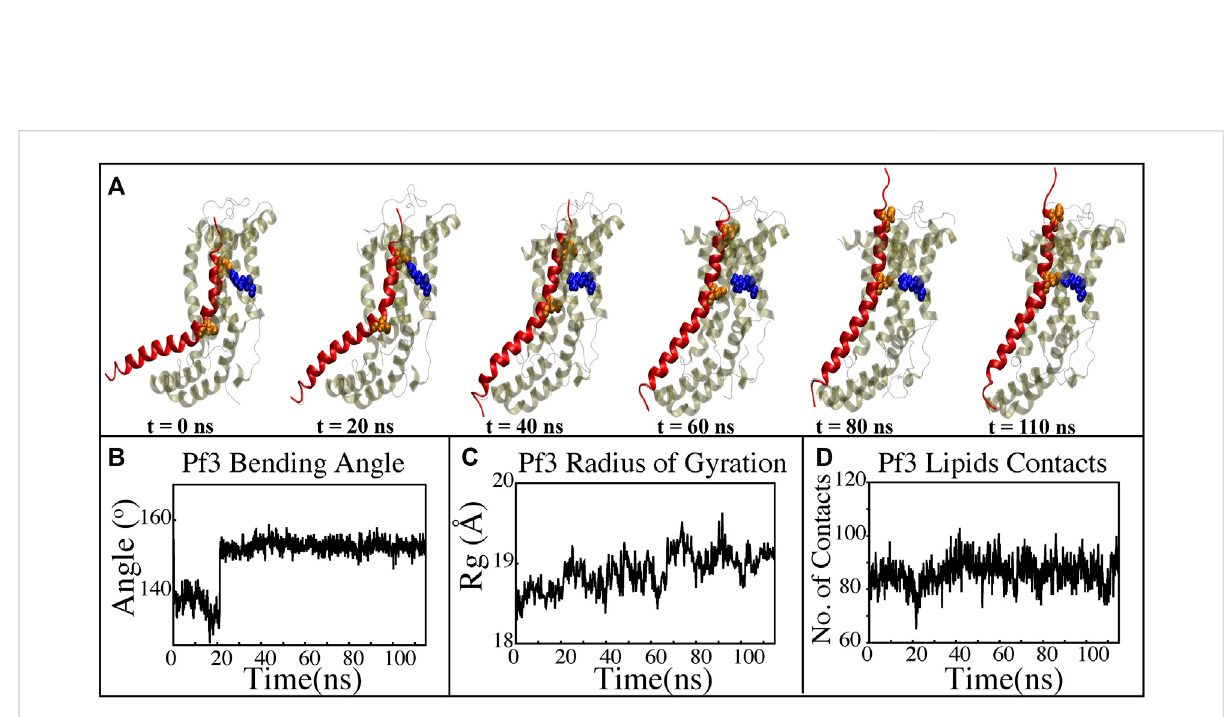
FIGURE 8 Characterizing the insertion process using targeted MD simulations. (A) Graphical representation of a series of targeted MD snapshots taken at different stages of the simulation. (B) Bending angle analysis of the Pf3 coat protein helix. (C) Radius of gyration of Pf3 coat protein peptide in the insertion process. (D) Interactions of Pf3 coat protein with lipid tails in the NE simulation